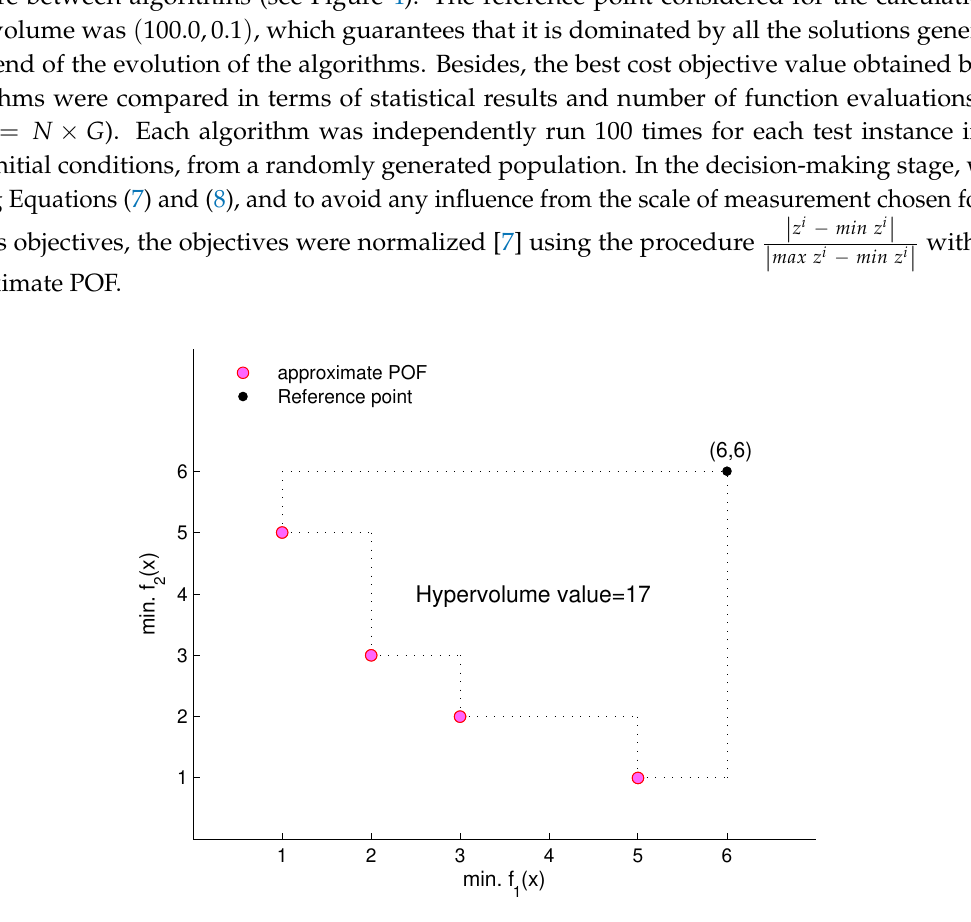
Figure 4. Evaluation of the hypervolume value with respect to the given reference point (6,6) on a two-objective minimization problem; larger hypervolume values indicate better quality of the approximate